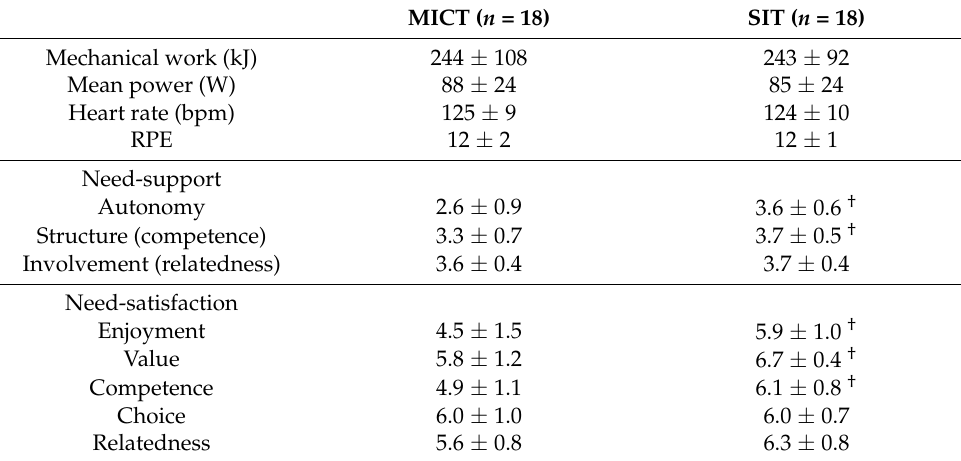
Table 1. Training session characteristics (physiological responses and psychological perceptions) of the 12-week SIT and MICT interventions (mean ± SD).